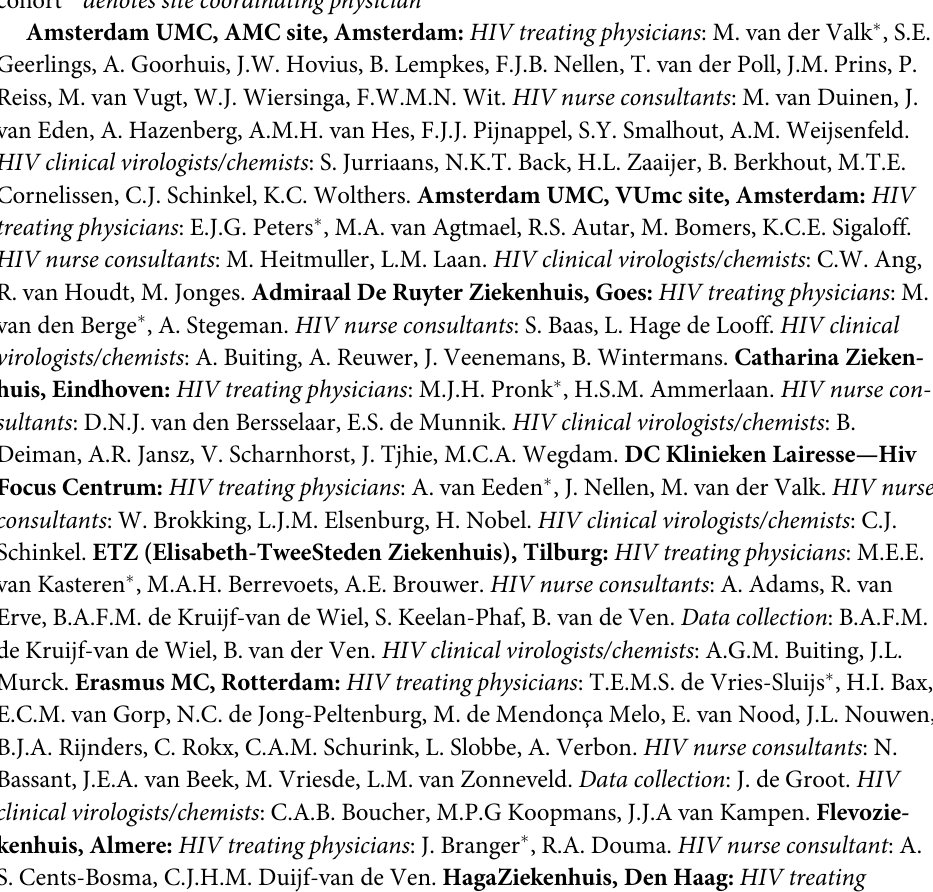
S1 Table. Cost of resources. Costs are presented per unit in € . S2 Table. Cost of co-medication. The cost of co-medications per day in € . Costs are calculated based on the average of the lowest and highest price of the available medication for a 70kg adult and 2018 list price. S3 Table. Cost of ART. The cost of ART per day in € . Costs are calculated based on the aver- age of the lowest and highest price of the available medication and 2018 list